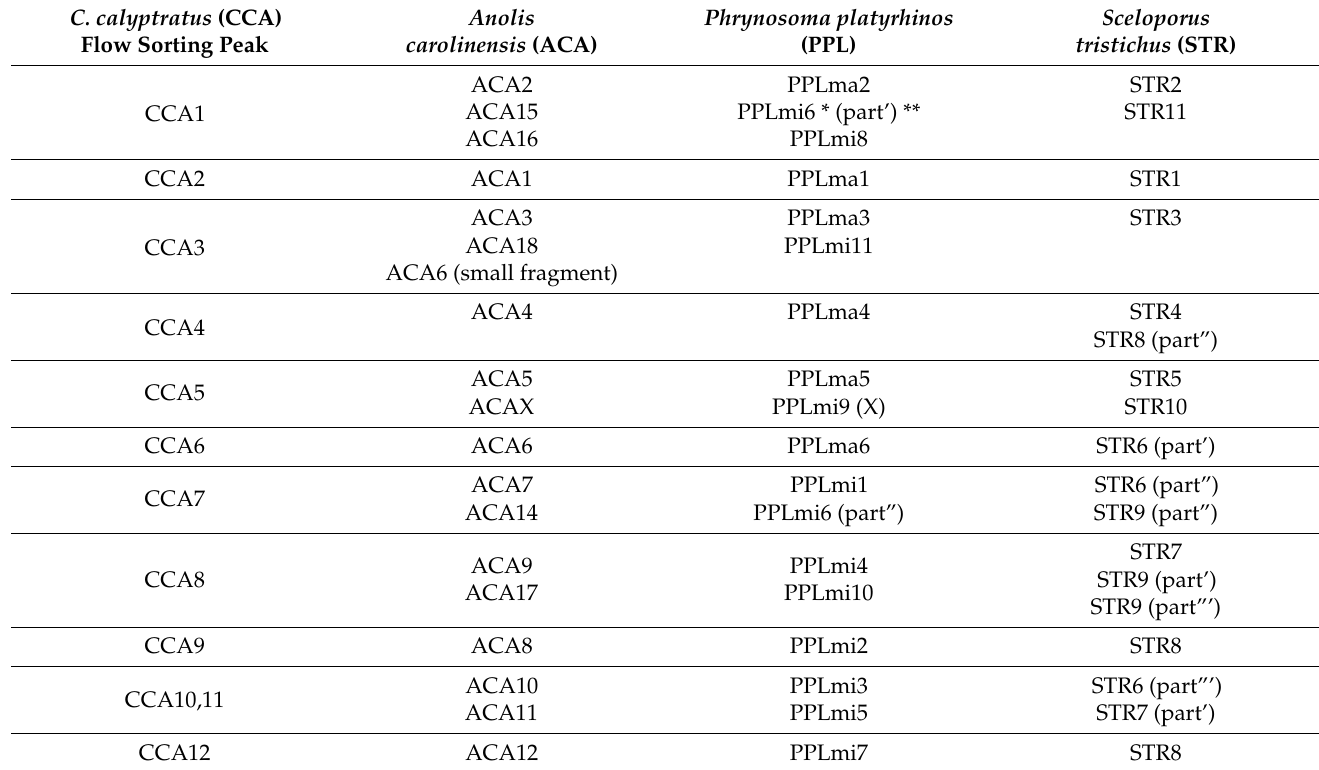
Table 1. The homology between the chromosomes of C. calyptratus and reference genomes was inferred from the NGS